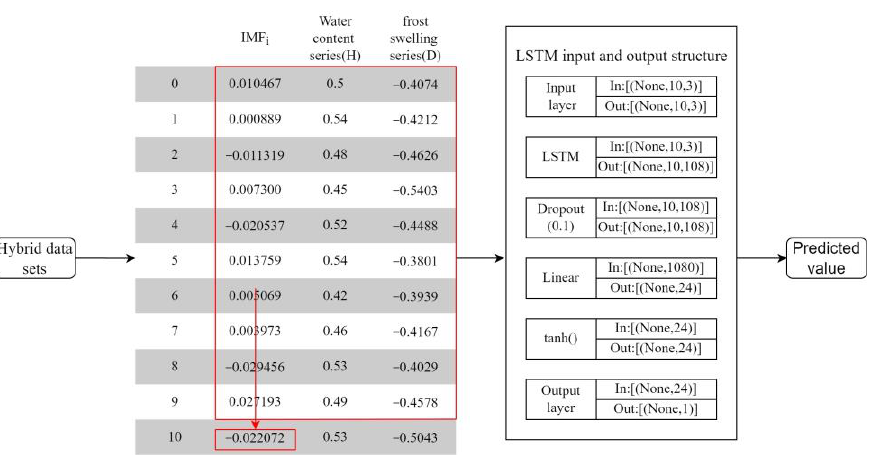
Figure 8. LSTM input and output schematic of IMF i .